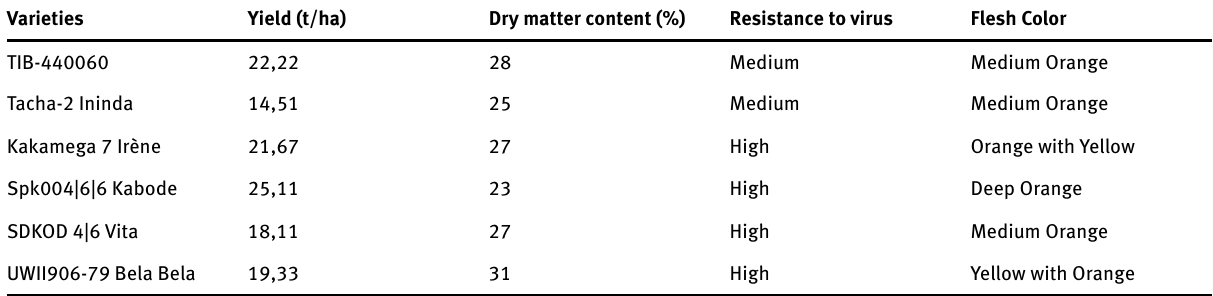
Table 2 : Genotypes main characteristics (recorded in research station)